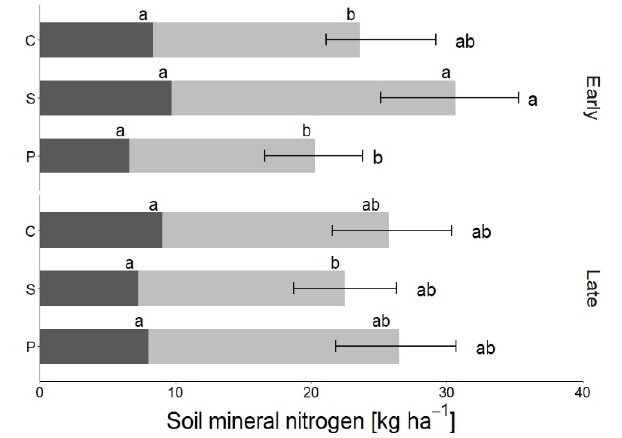
Figure 9. Autumn soil mineral nitrogen (SMN) at 0–90 cm as treatment averages over all experiments. Colour coding indicates the amounts in each measured layer: 0–30, 30–60, and 60–90, going from light to dark grey. C = control (no service crop, SC), S = frost-sensitive annual SCs, P = perennial SCs. Error bars show the 95% confidence interval whole profile SMN. Significance letters show the statistical difference between treatments in each soil layer and should not be compared between layers.